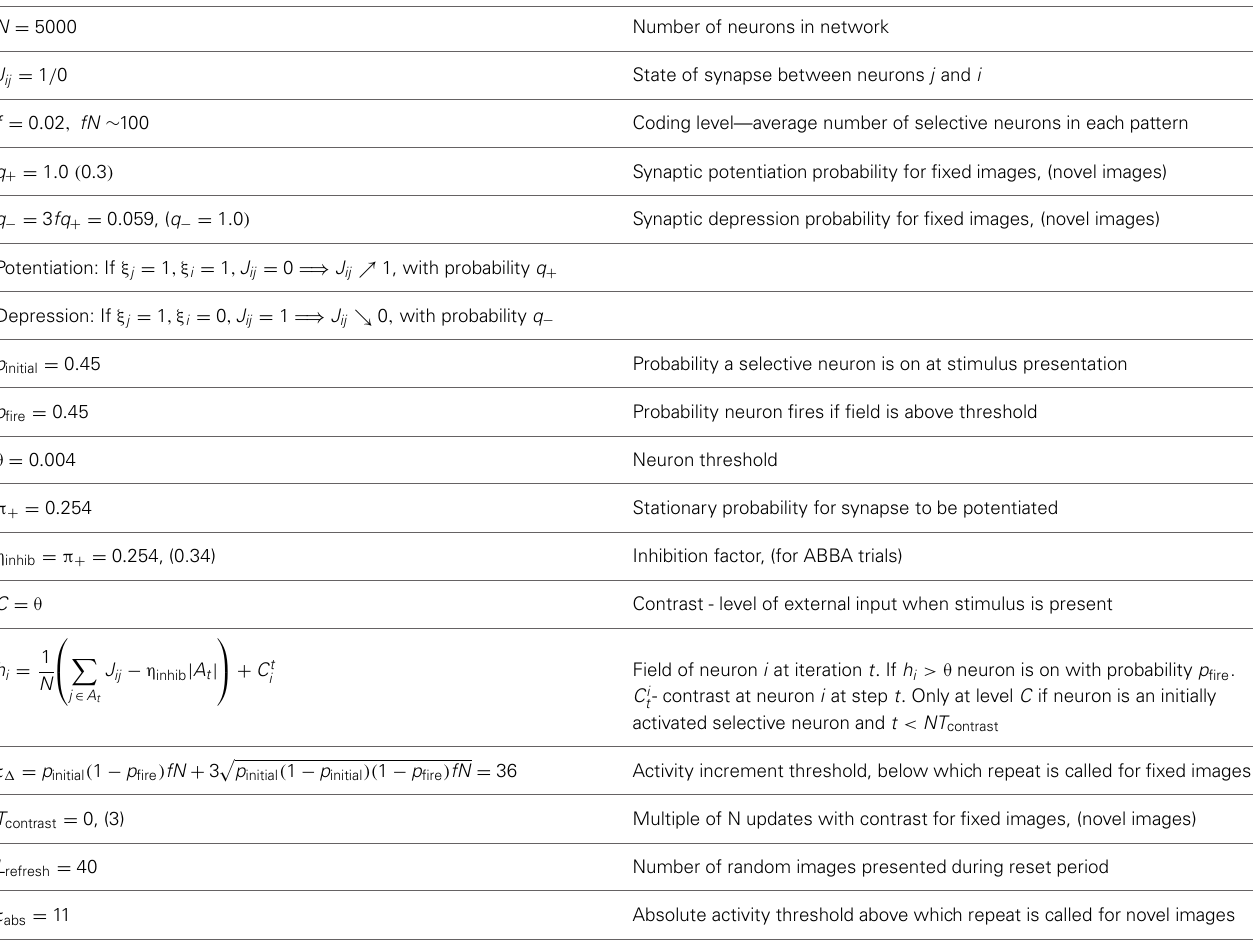
Table 1 | Notation formulas and default parameter settings for neural and synaptic dynamics of network and modifications for DMS, ABBA, DMMS trials with novel